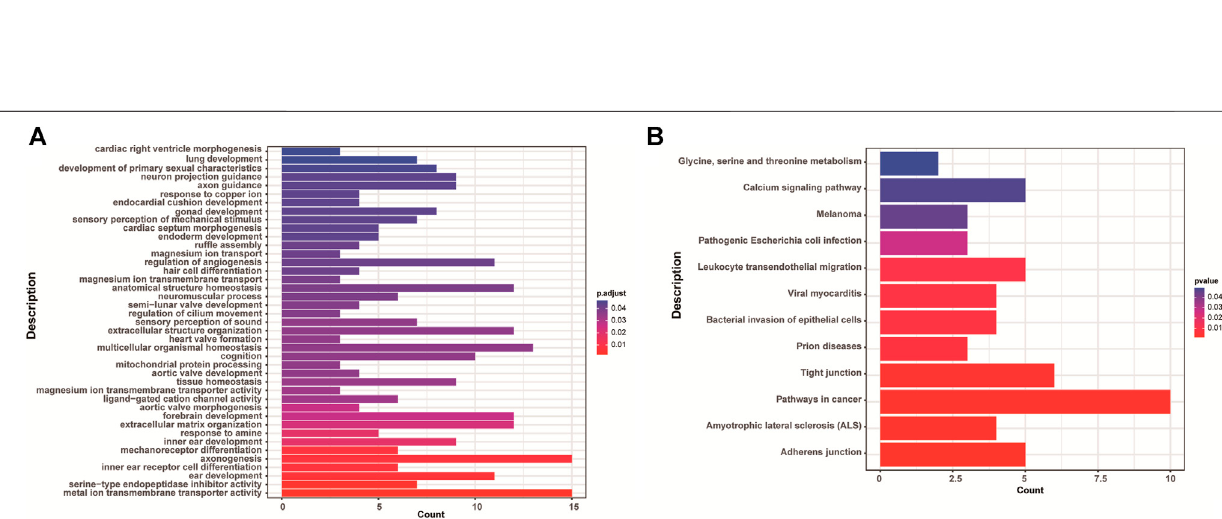
FIGURE 2 | Venn diagrams of genes in VOUS + pathogenic CNV regions depending on age of pregnant women (A) and different pregnancies (B) .